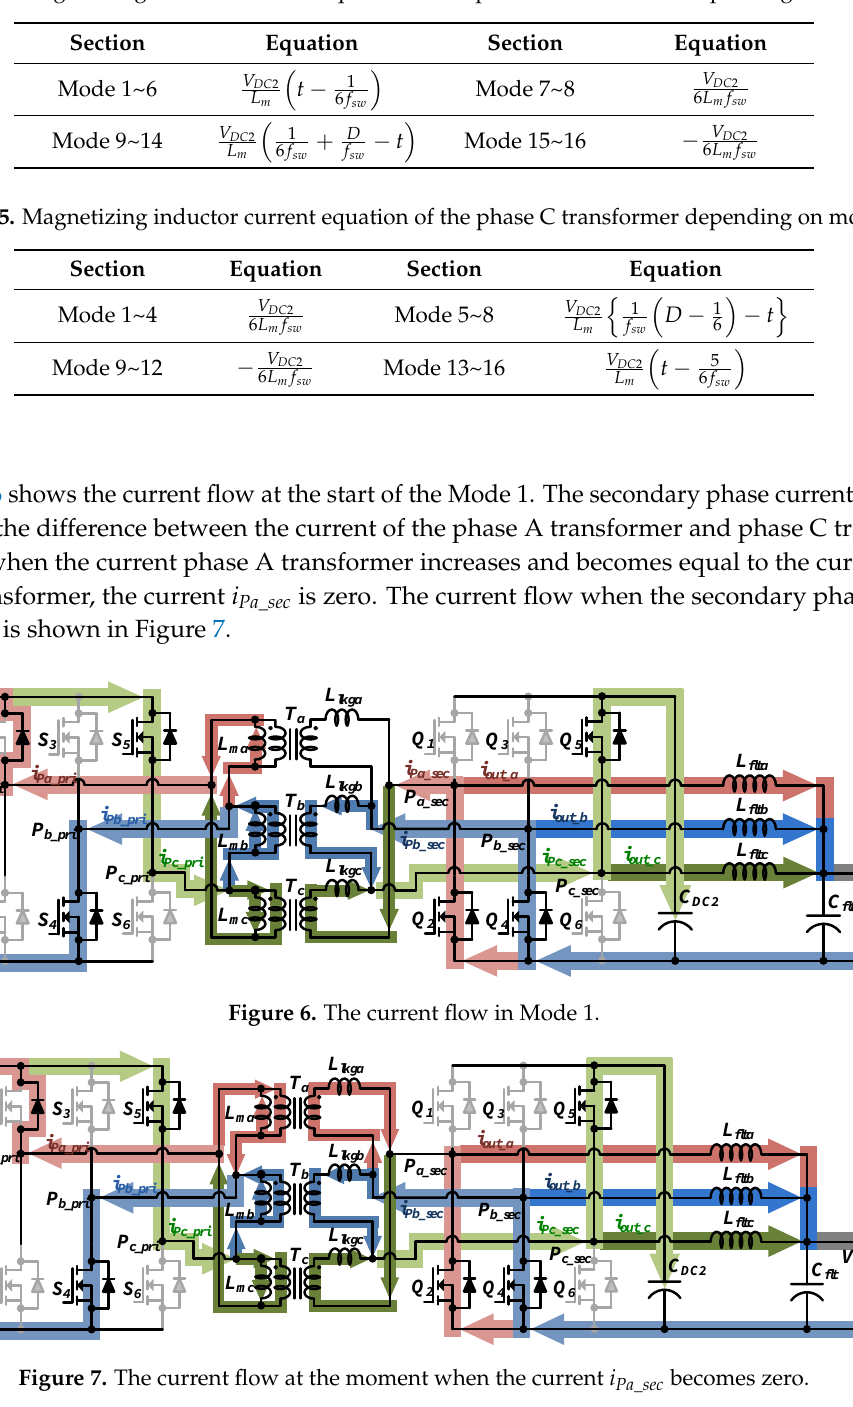
Table 4. Magnetizing inductor current equation of the phase A transformer depending on mode.